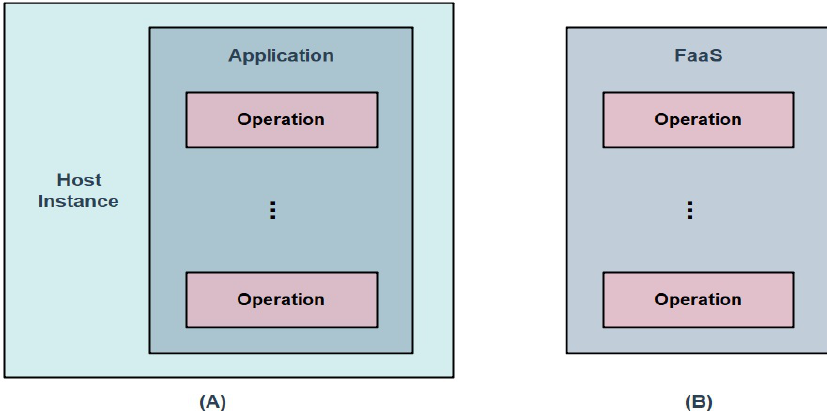
Figure 1. ( A ) represents the traditional approach for the deployment of software on the server-side; ( B ) depicts Functions-as-a-service (FaaS)-based approach for deploying the software pertaining to different